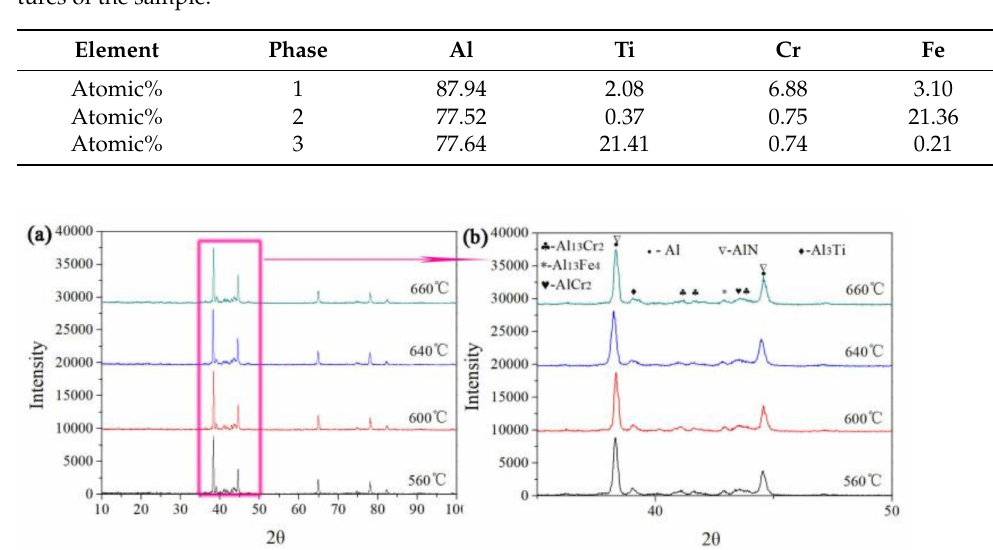
Table 1. The energy dispersive spectroscopy (EDS) of the three phases of the arrow in the microstruc- tures of the sample.